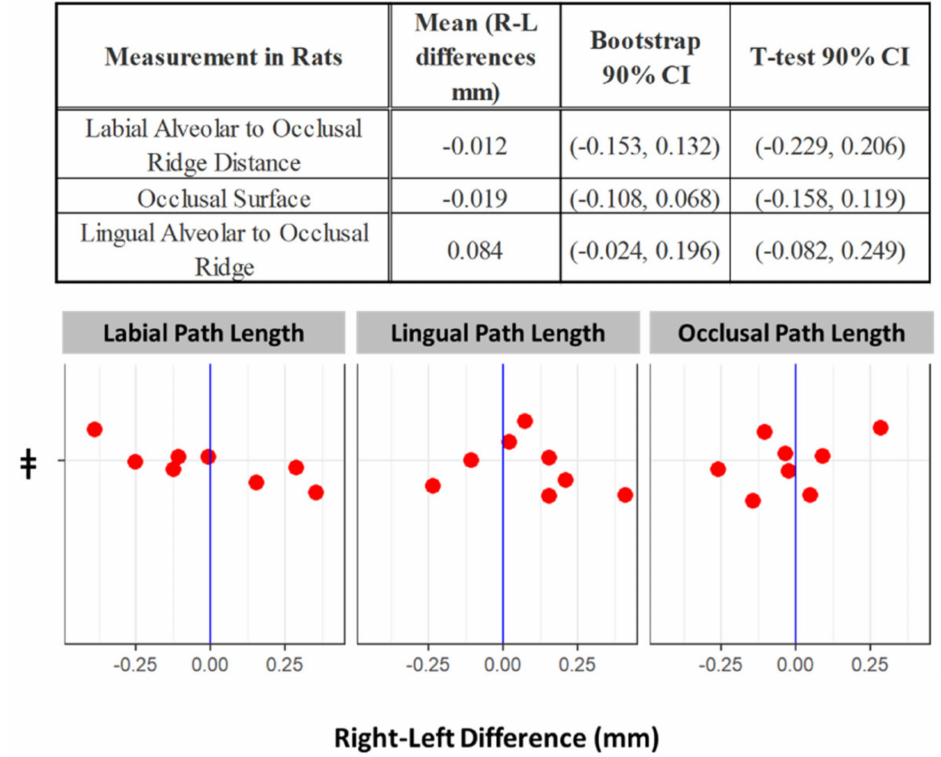
Figure 3. Difference between right and left rat incisors at baseline with 90% confidence intervals. The dots in the plot below describe the left-right differences of individual rats in the 3 different measures. } Note that the vertical positions of the data points within each measurement category allow for better visualization of data but carry no